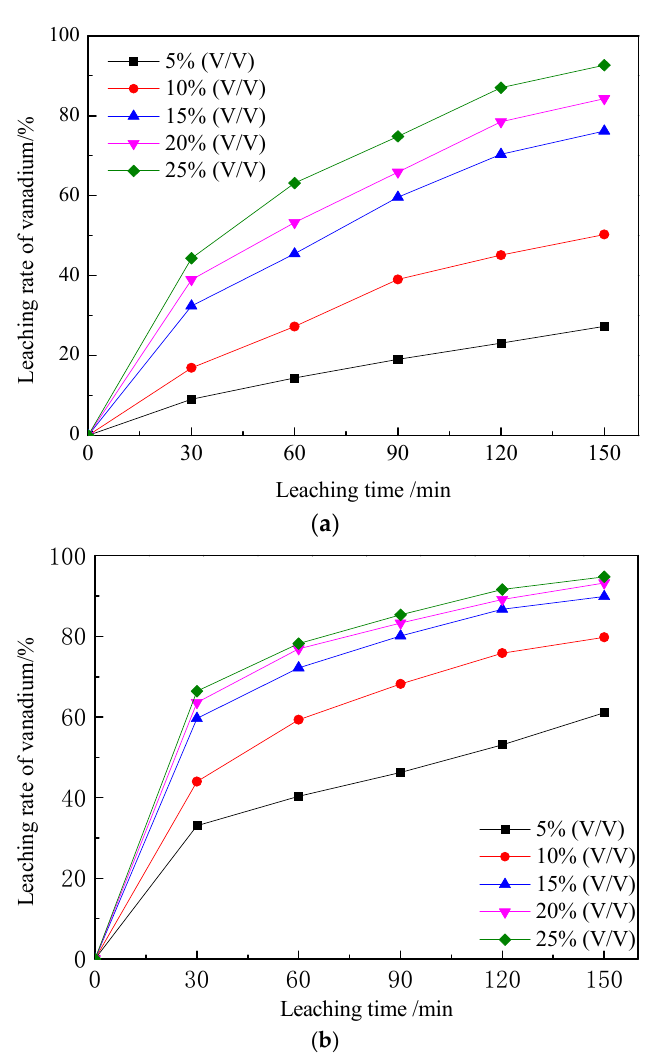
Figure 9. Relationship between leaching rate and leaching time of vanadium at different sulfuric acid concentrations. ( a ) Blank roasting clinker; ( b ) Calcified roasting clinker.